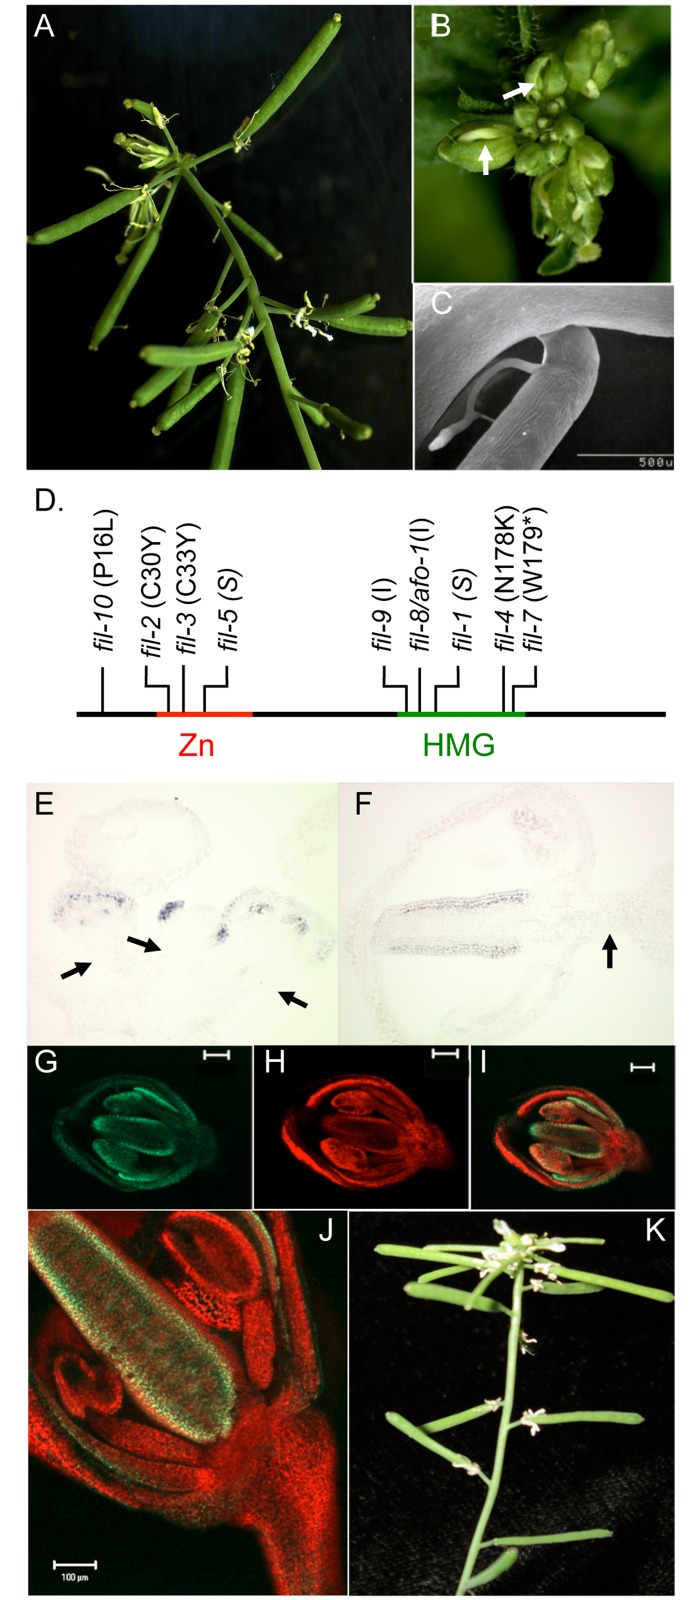
Mutations in FIL and LAS affect inflorescence architecture in a similar fashion.(A-C) bp er fil-4 plants showing elongated pedicels (A), upward-oriented floral buds with gaps between sepals (arrow; B) and bends in pedicels at filamentous organs (C). (D) Locations of characterized mutations in the FIL gene. The nature of each mutation is shown in parentheses: I = insertional mutant, S = splice junction mutant; the asterisk represents a stop codon. (E-F) In situ hybridization with a FIL probe showing expression in sepal primordia (central bud) and in floral organs of older, peripheral buds (E), and gynoecium valve expression in a stage 9 pedicel (F). Note the absence of FIL expression in pedicel tissue (arrows) at stages that precede the period of pedicel elongation [59]. (G-I) A collage of a stage 9 bud from a transgenic plant expressing a FILpro::FIL::GFP transgene. The left panel shows FIL::GFP expression on the abaxial side of floral organs; the middle panel is the chlorophyll autofluorescence (red channel) and the right panel is the merged image. (J) Mature flower illustrating FIL::GFP in floral organs only. (K) The bp er las-11 triple mutant exhibits a phenotype nearly identical to that of bp er fil-10.